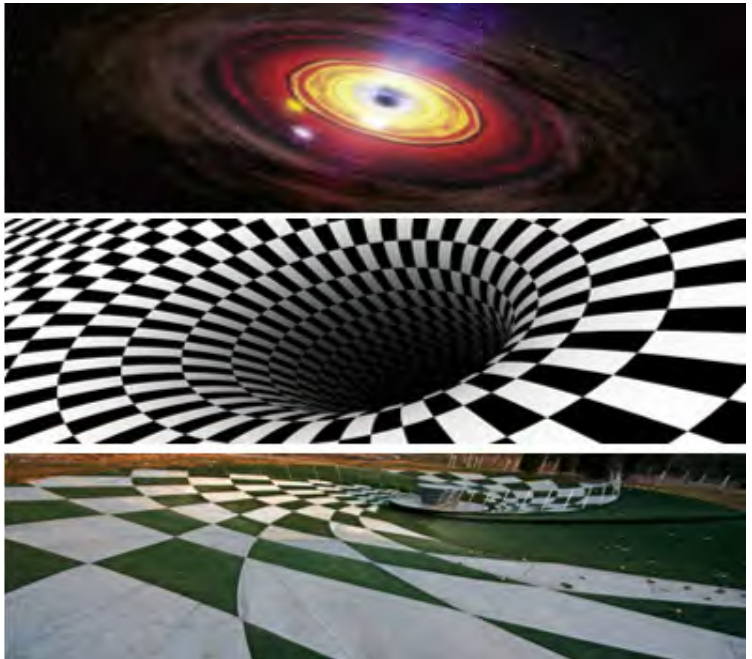
Figure 8. Three steps of inspiring the black hole phenomenon at the landscape of Cosmogenesis Park.